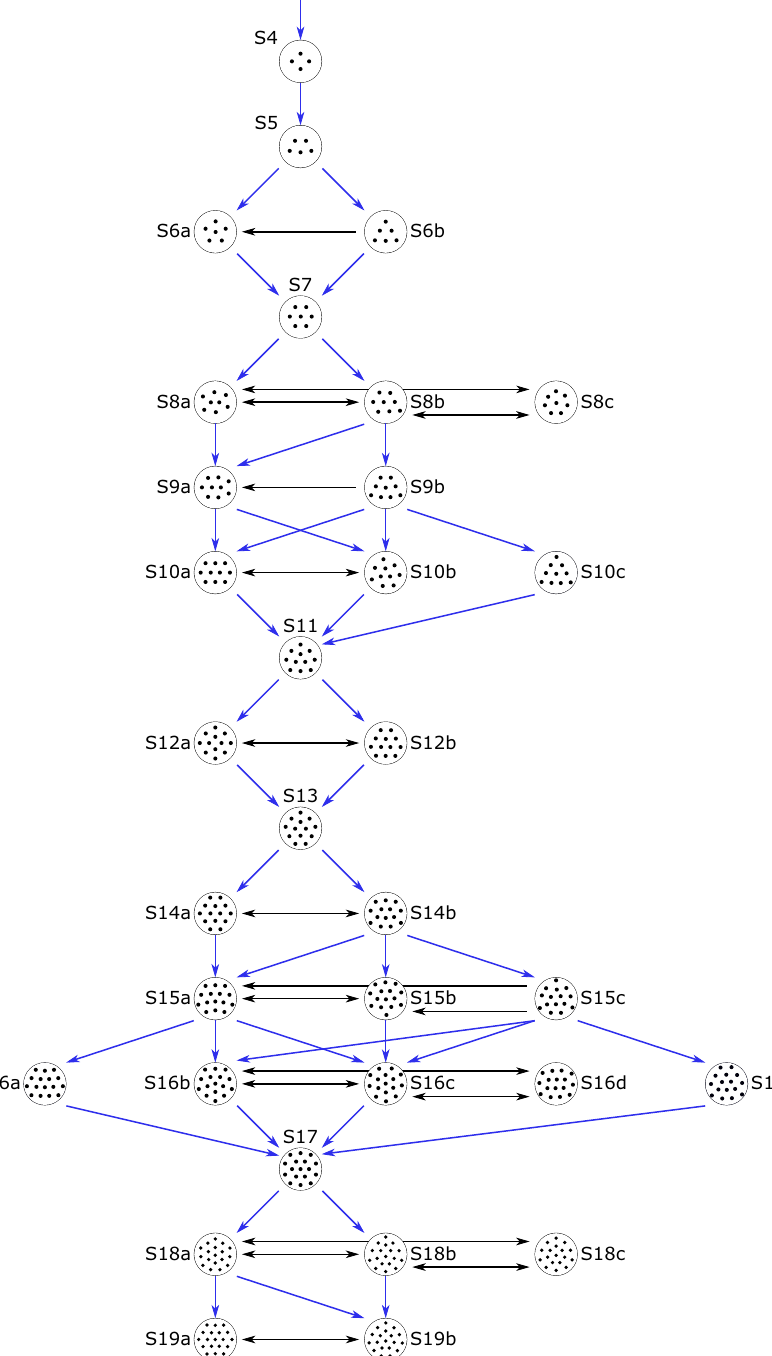
3 to Figure 2. The various structures adopted by a floating crystal for a number of particles between N = 19 . Each state is named as the letter “S” followed by a number, which indicates the number of particles, N = and, if necessary, a letter to distinguish different states with the same number of particles. The possible transfers between states having the same number N of particles (black arrows) are obtained with the magnetic reconfiguration method. Double black arrows indicate that it is possible to switch from one state to another and vice versa. Single black arrows give the only obtained direction of transition between the two states. The possible 1 particles (blue arrows) are obtained with the transfers from states having N particles to ones having N + controlled growth